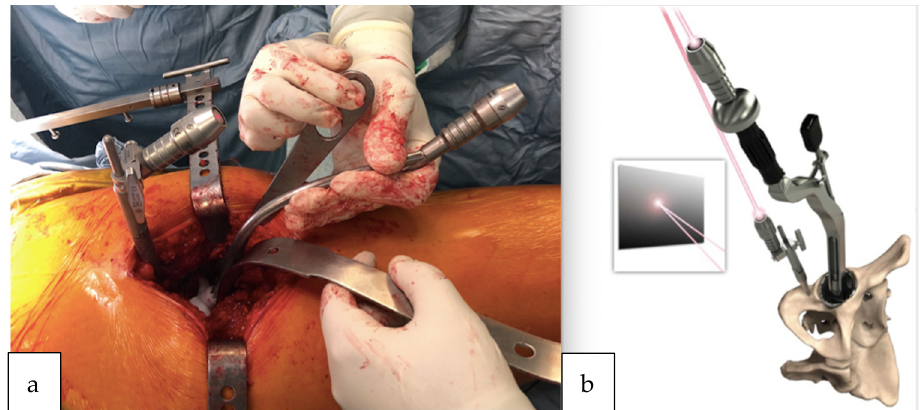
Figure 5. ( a ) Pelvic reference pin and acetabular guide introducer topped with the laser pointer. The lights of both lasers were made to converge on the wall of the theater. ( b ) Demonstration of the removable laser adapted also to the top of the impaction handle; the coincidence of the lights is checked again to guide the cup impaction.